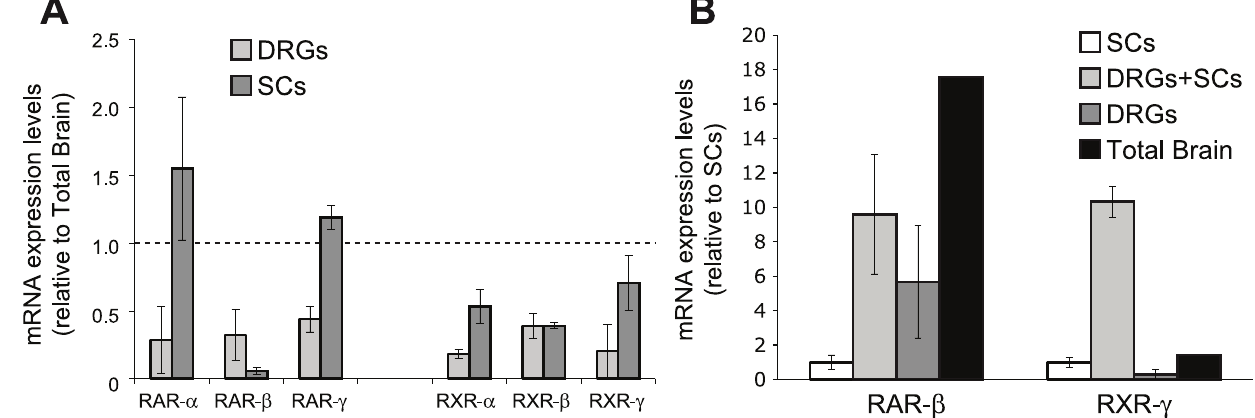
Figure 1. RXR- c expression is increased in DRGN/SC cocultures. ( A ) The mRNA levels of all six RARs and RXRs were analyzed by Q-RT-PCR. The results are shown as the mean value 6 SD relative to the levels found in whole adult rat brain (dashed line). ( B ) The mRNA levels of RAR- b and RXR- c were analyzed by Q-RT-PCR in isolated SCs or myelination-competent DRGN/SC cocultures and compared to isolated DRG neurons and total adult rat brain. The results are shown as the mean value 6 SEM relative to the levels found in isolated SCs.